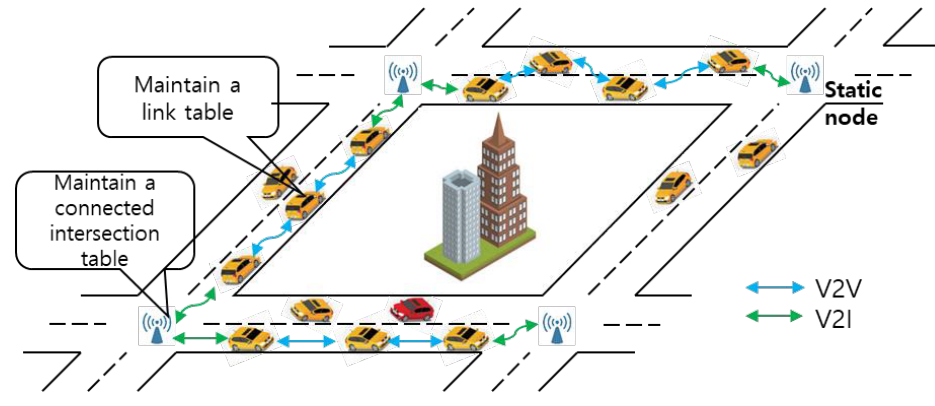
Figure 1. The architecture of the routing protocol.